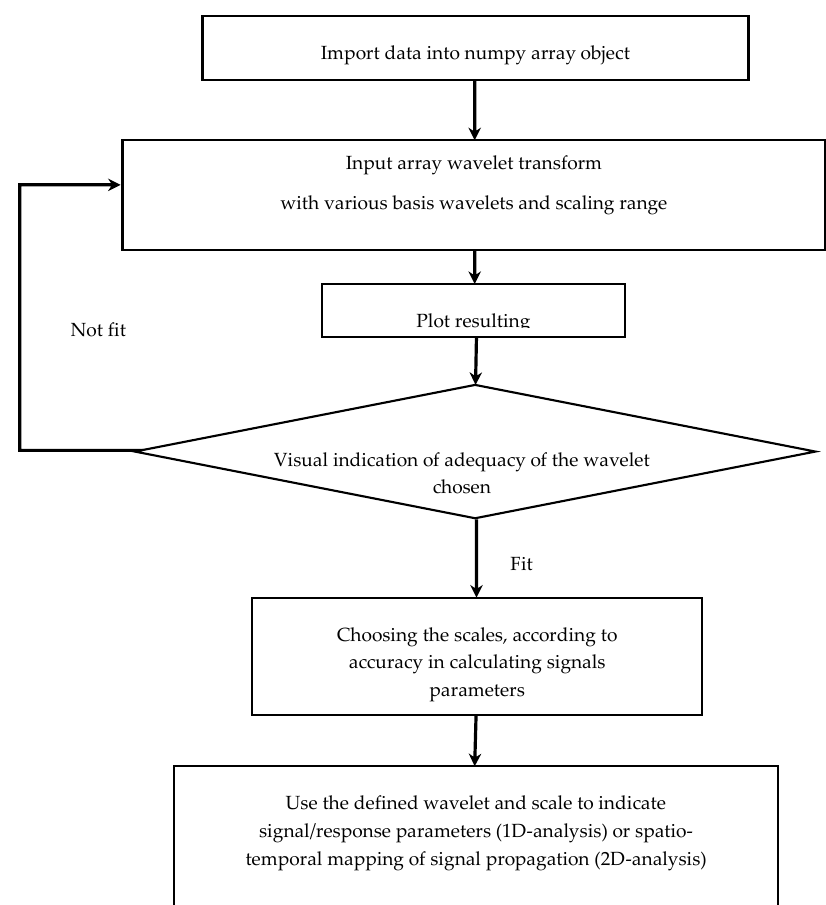
Figure 1. The algorithm of the continuous wavelet transform of the input record. The input data were the records of electric potentials and parameters of photosynthetic activity: quantum yields of photosystems I and II, and non-photochemical quenching. The e ff ectiveness of machine processing was verified using the Bland–Altman